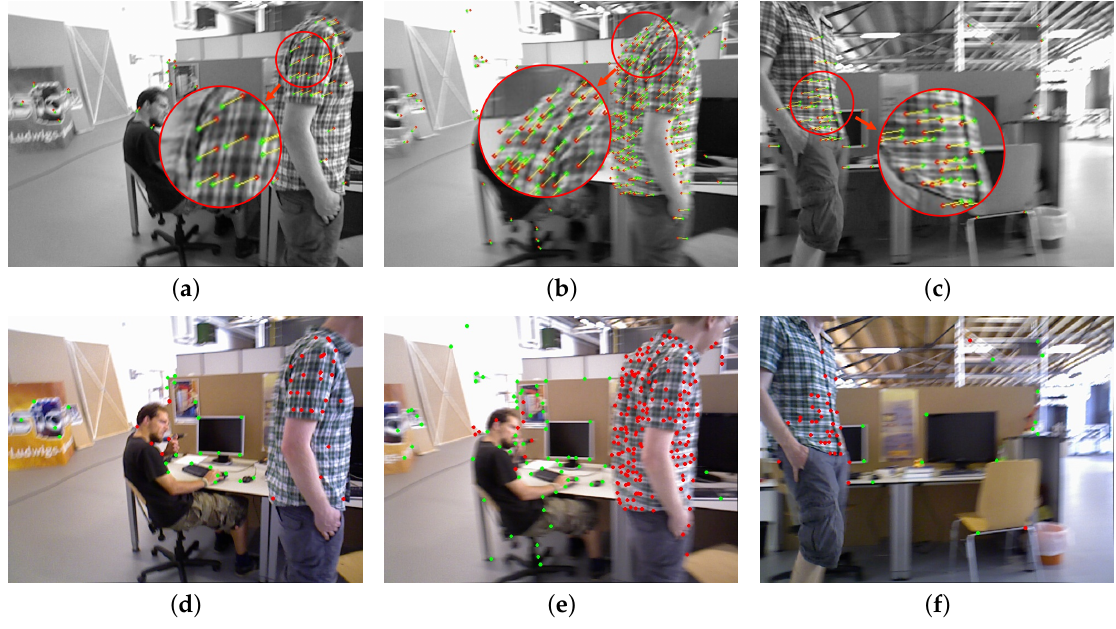
Figure 6. ( a – c ) Three cases for object motion. The yellow line between the red and green endpoints in the figure is the offset vector in Figure 5; ( d – f ) dynamic point extraction results of ( a – c ). Static feature points are displayed in green, and dynamic points are displayed in red. The figure is best viewed in